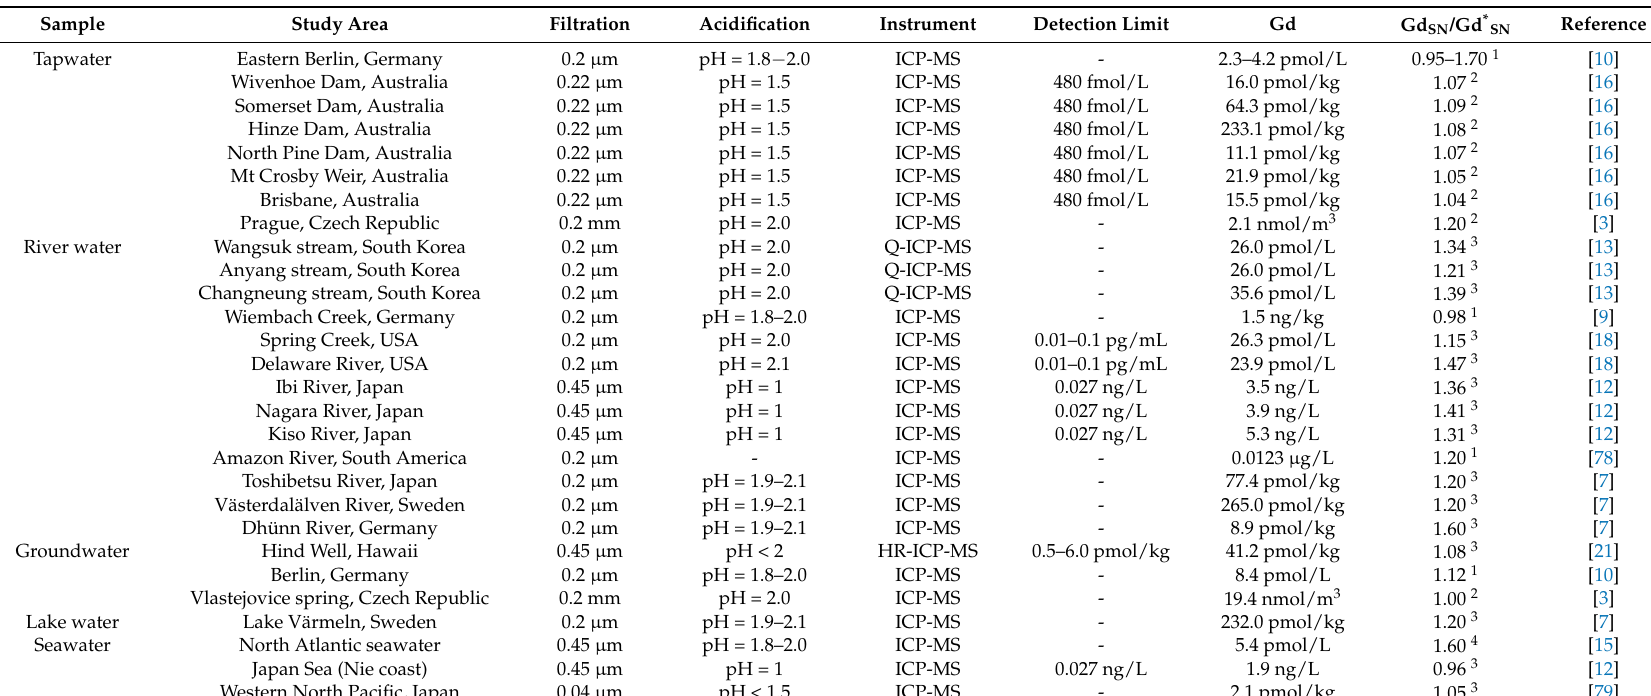
Table 2. Total Gd concentrations and Gd anomalies reported in uncontaminated aqueous samples. The subscript, SN, denotes the normalization to the Gd content in the continental crust (regularly PAAS was used) and the superscript * denotes the natural background